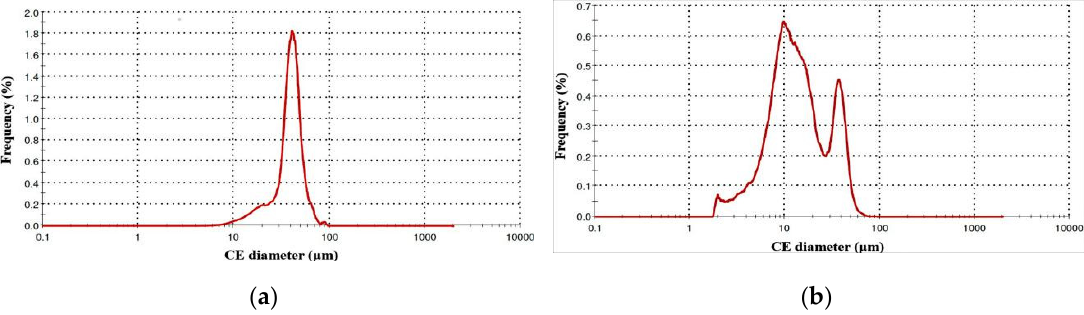
Figure 5. Diameter report of 316L particles: ( a ) Volume distribution method; ( b ) Number distribution method. Table 2. Diameter report of 316L particles.